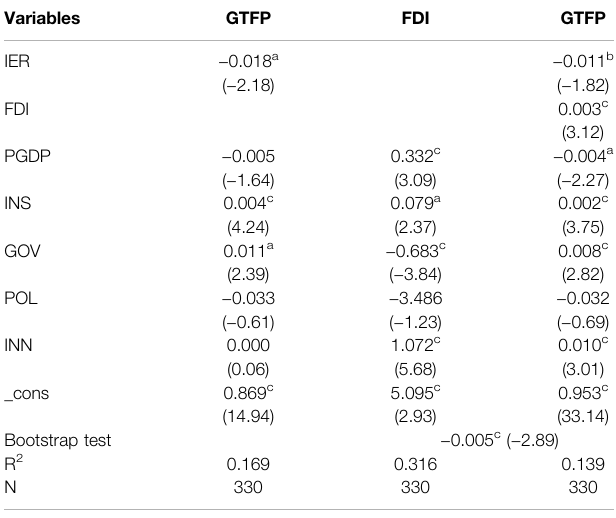
TABLE 11 | Test of the mediating effect of command-based environmental regulations on GTFP.